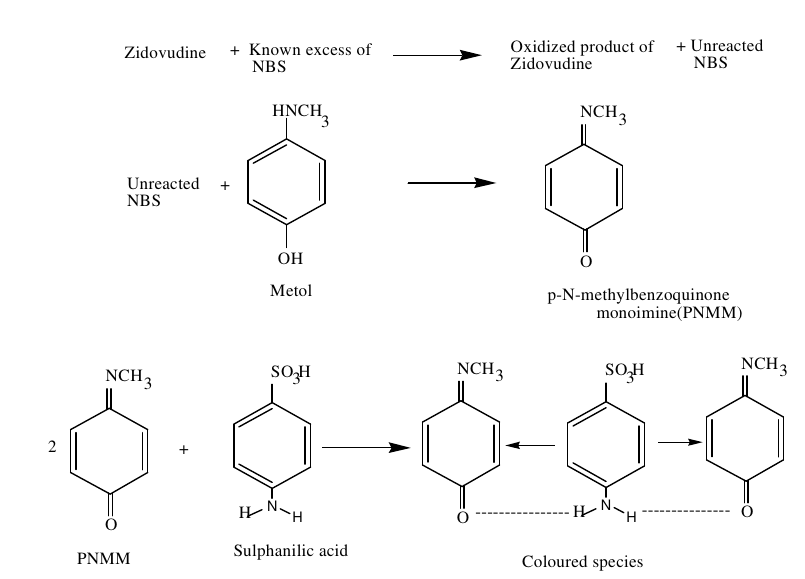
Figure 1 . Probable reaction